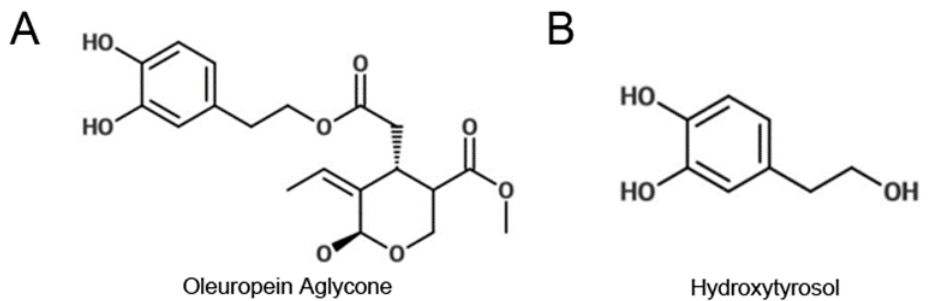
Figure 1. Chemical structure of ( A ) oleuropein aglycone and ( B ) hydroxytyrosol.